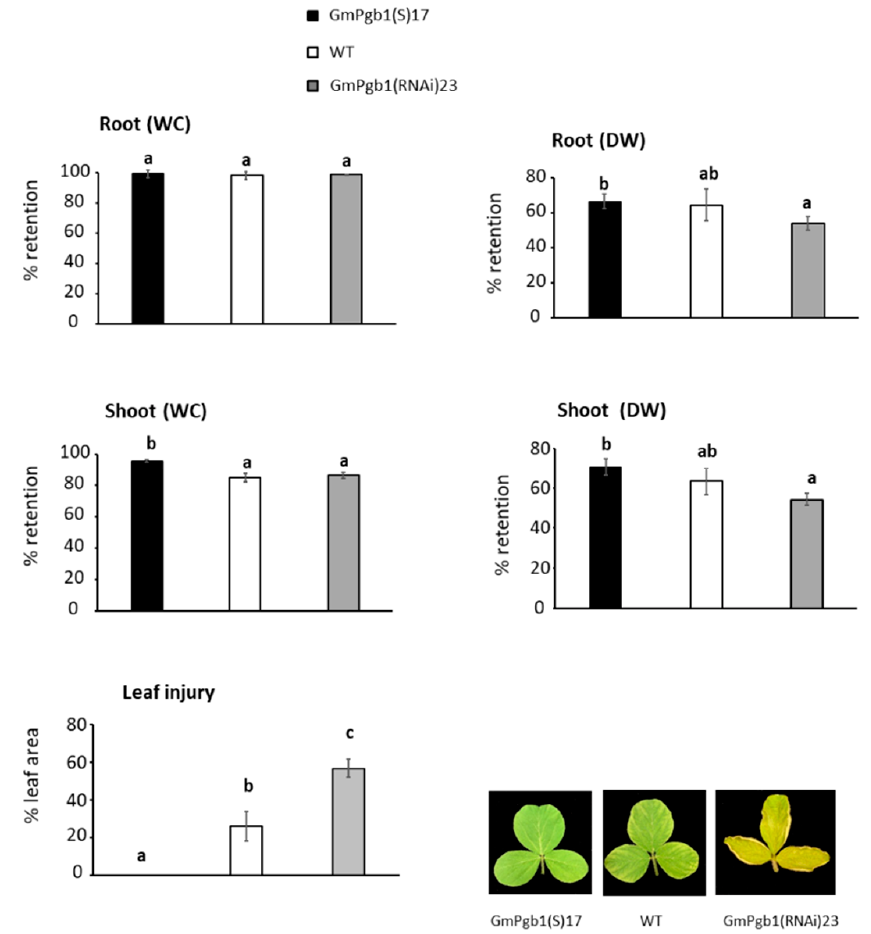
Morphological differences between the lines were visible after seven days of stress. Over- expression of GmPgb1 limited the Na 2 SO 4 depression of the shoot water content (WC) and the root and shoot dry weight, which were more severe in the WT and GmPgb1(RNAi)23 lines (Figure 3). Leaf injury, not noticeable in leaves of the GmPgb1(S)17 line exposed to salin- ity for seven days, was apparent in the other two lines, and especially in leaves of the GmPgb1(RNAi)23 plants (Figure 3).